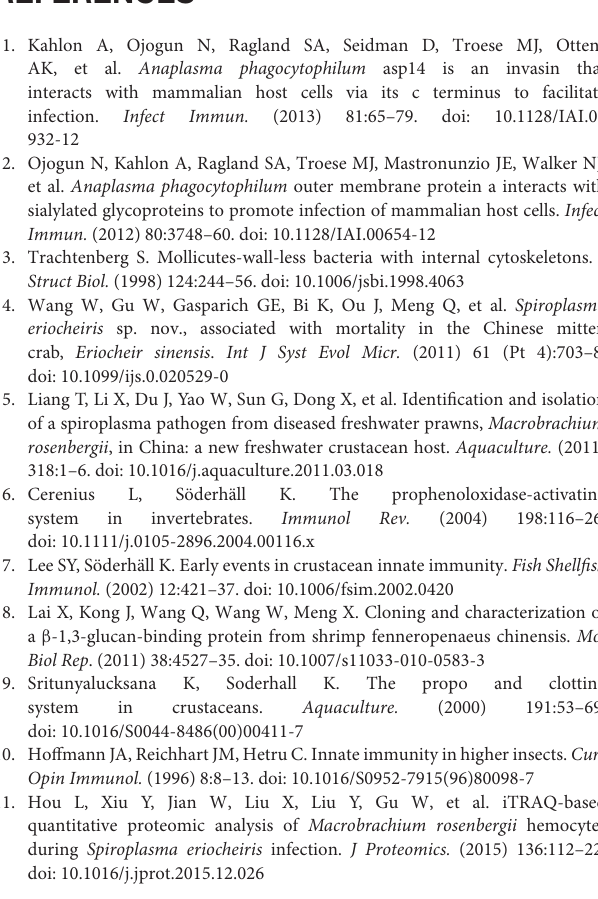
Figure S1 | Mass spectrometry analysis of receptor proteins. Red letters represent successful blast with NCBInr. (A) Ras-related nuclear protein (Ran), similar to Marsupenaeus japonicus Ran with a shared coverage of 18%; (B) lipopolysaccharide and beta-1,3-glucan binding protein (LGBP), similar to M. rosenbergii LGBP with a shared coverage of 8%; (C) beta-actin protein, similar to Litopenaeus vannamei beta-actin with a shared coverage of 37%; (D) prophenoloxidase protein (proPO), similar to M. rosenbergii proPO with a shared coverage of 13%; (E) beta tubulin protein, to Penaeus monodon beta tubulin with a shared coverage of 28%; (F) alpha-tubulin protein, similar to Eriocheir sinensis alpha-tubulin with a shared coverage of 24 %; (G) alpha-tubulin protein, similar to Penaeus monodon alpha-tubulin with a shared coverage of 10%. Figure S2 | Mass spectrometry of ligand proteins. Red letters represent successful blast with NCBInr. (A) 50 kDa band was identified as enolase, shared